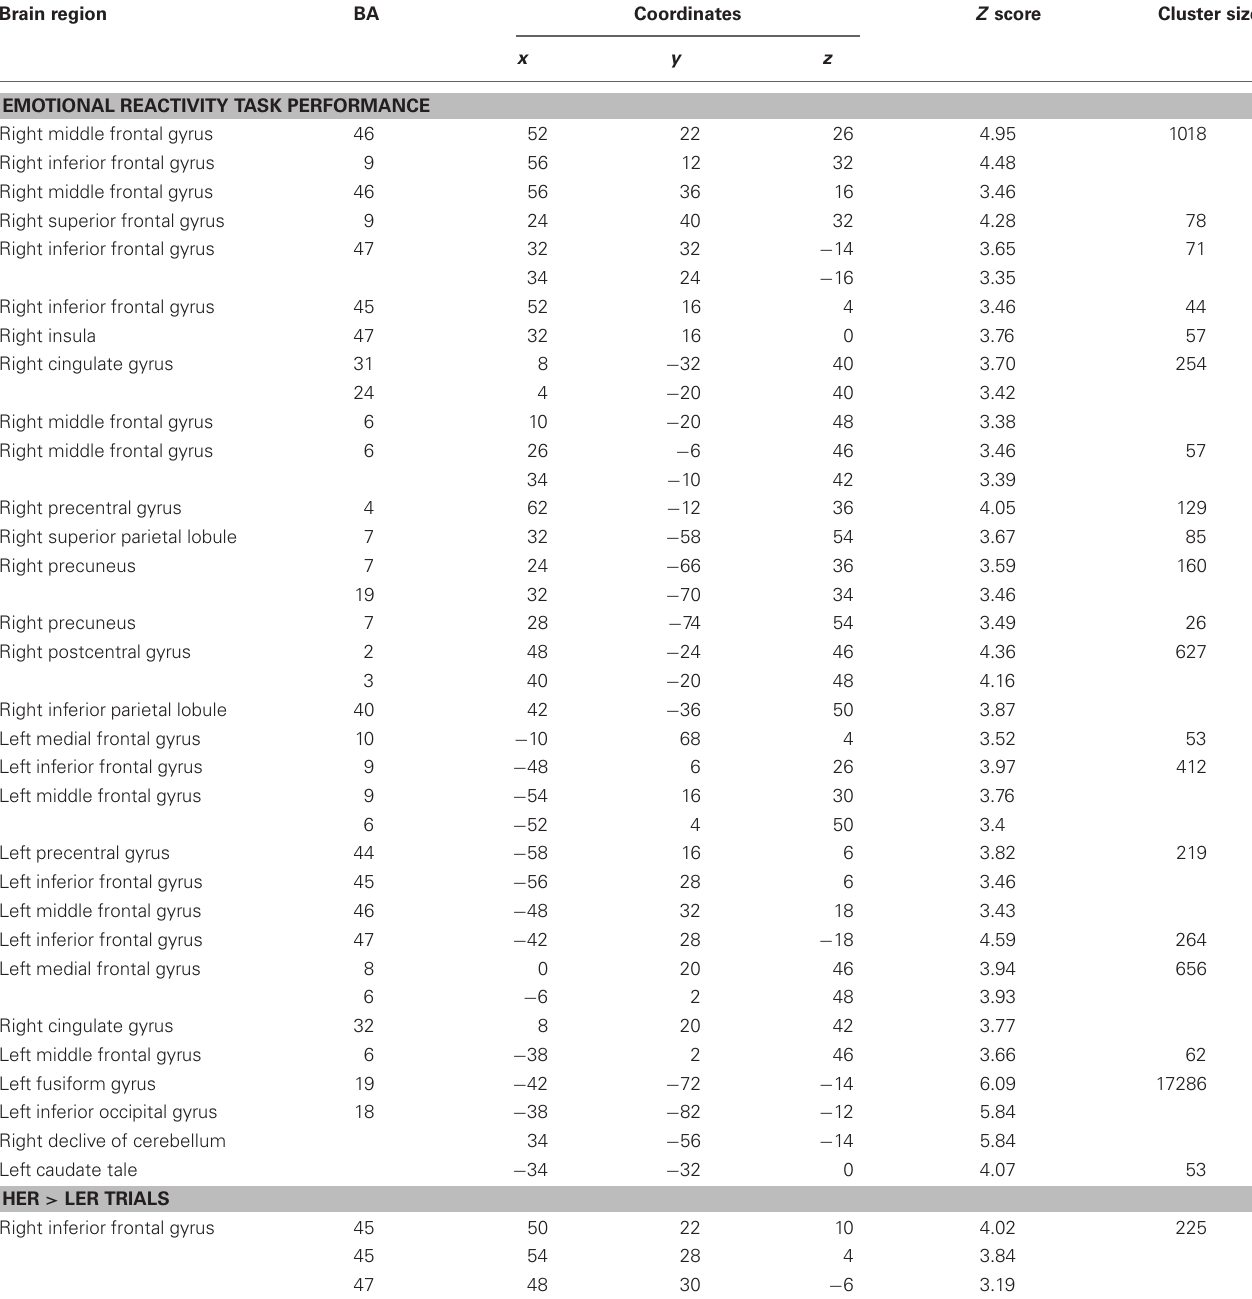
Table 2 | Activations during the emotional reactivity task after baseline sleep. Brain